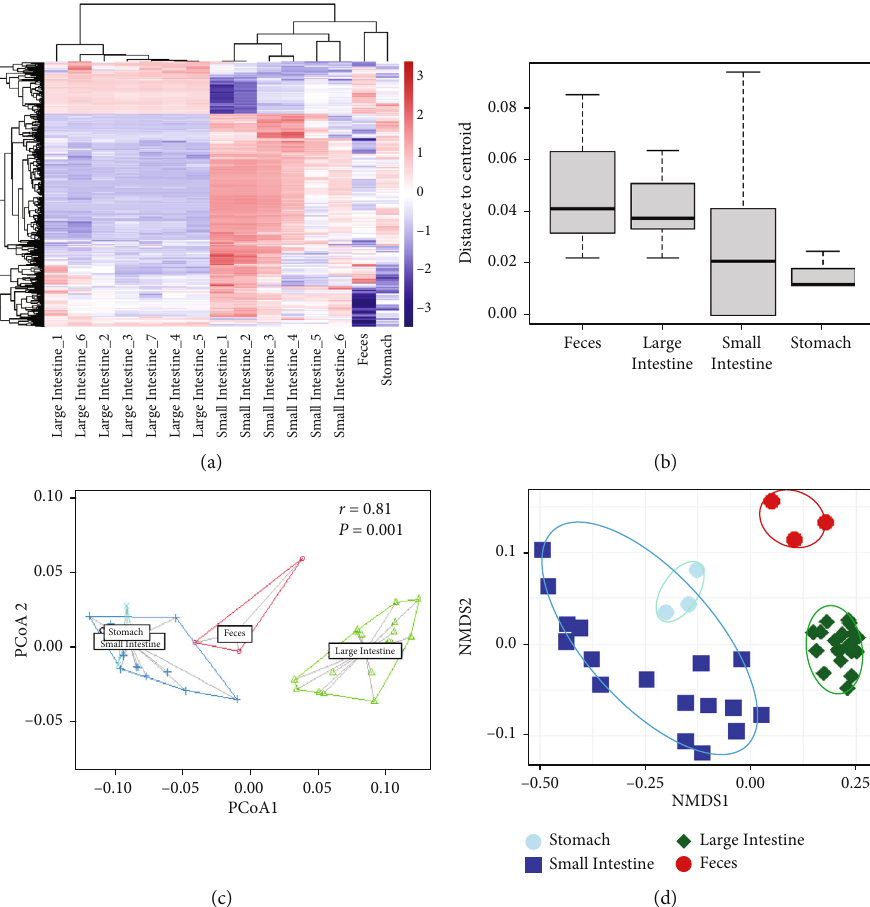
Figure 5: The location-speci fi c chemical diversity in the GI tracts. (a) Heatmap of the chemicals in each location of the GI tracts based on the Bray-Curtis distance matrix. (b) β -Diversity centroid of LC-MS/MS samples from each GI sites. Adonis < 0 : 001 . (c) Similarity of chemical compounds from GI sites based on PCoA, R 2 = 0 : 81 , P = 0 : 001 . (d) Nonmetric multidimensional scaling (NMDS) plot of the chemicals showing location-speci fi c variation. The relative quantities and identities of chemicals detected by ultra-high-resolution LC- MS/MS in each location of the GI tracts were used for the statistical analyses. The sampling locations within the GI tract were determined based on the anatomical feature: the stomach, the duodenum (small intestine_1), the jejunum (small intestine_2 ~ small intestine_5), the ileum (small intestine_6), the cecum (large intestine_1), the colon (large intestine_2 ~ large intestine_6), and the rectum (large intestine_7). The anatomical di ff erences between each location are shown in Figure